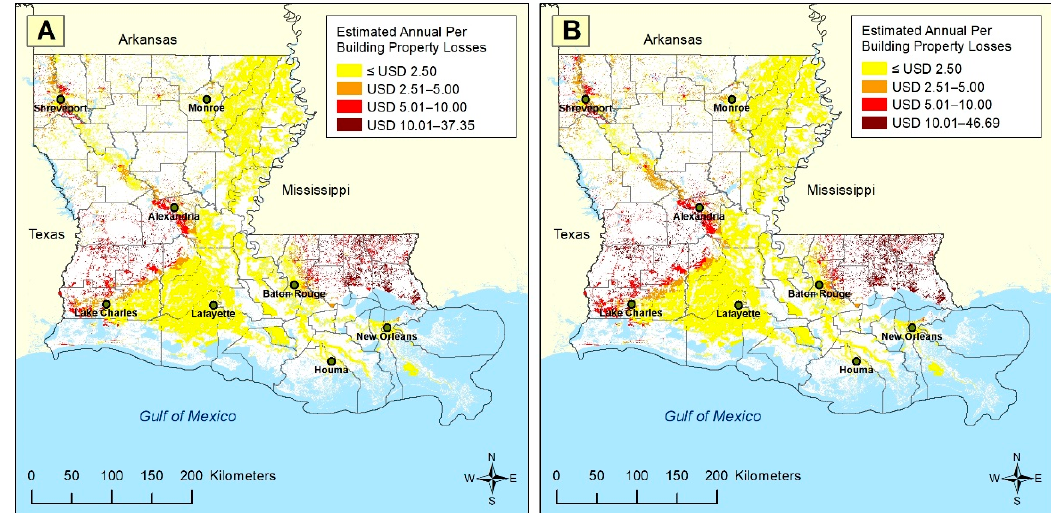
Figure 5. Estimated annual per building property loss (in 2010 USD) due to wildfire by census block: ( A ) historical (1992–2015), and ( B ) 2050.